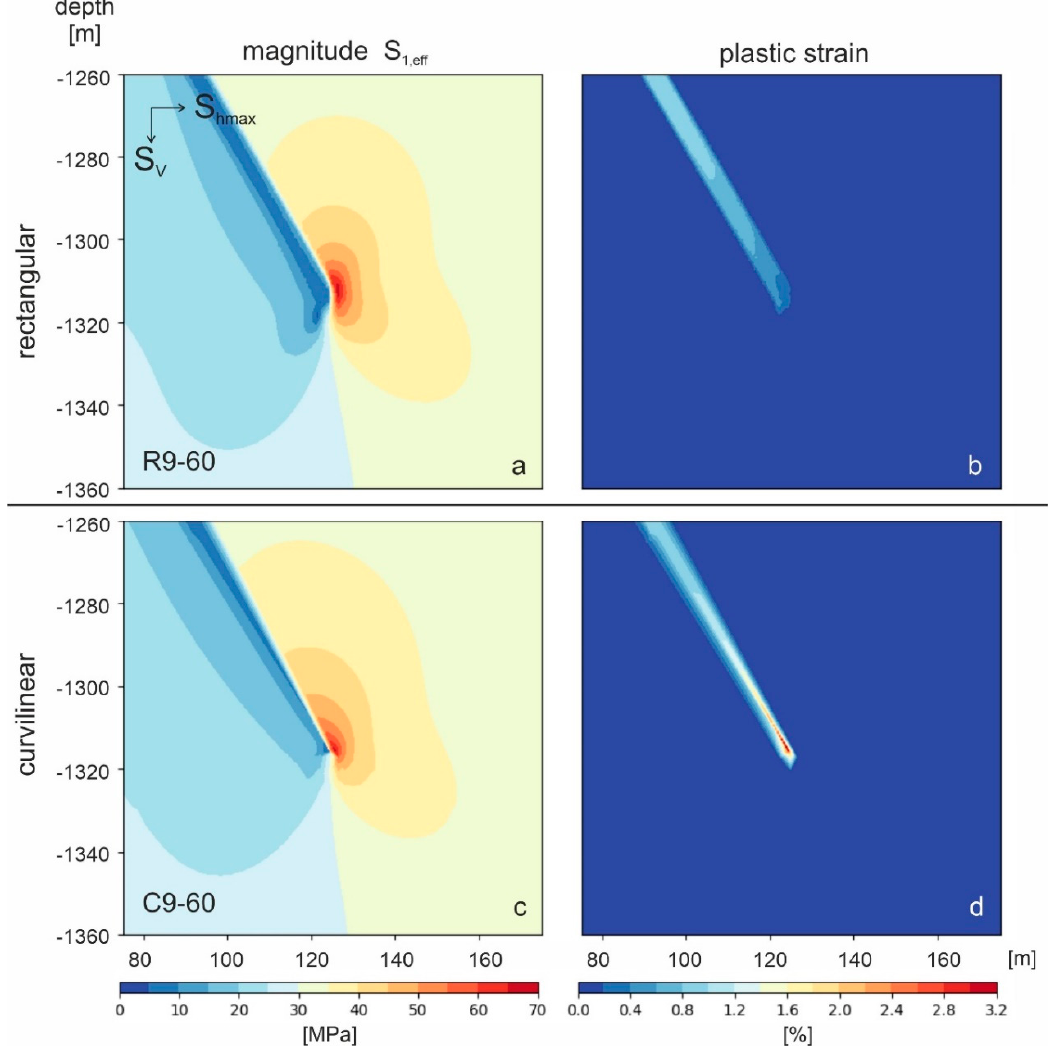
Figure 11. Detailed view on the results after the last load step for a 9-element wide fault zone with 60° dip embedded with different grids. Rectangular grid: ( a ) magnitude S 1,eff ( b ) von Mises plastic strain. Curvilinear grid: ( c ) magnitude S 1,eff ( d ) von Mises plastic strain.